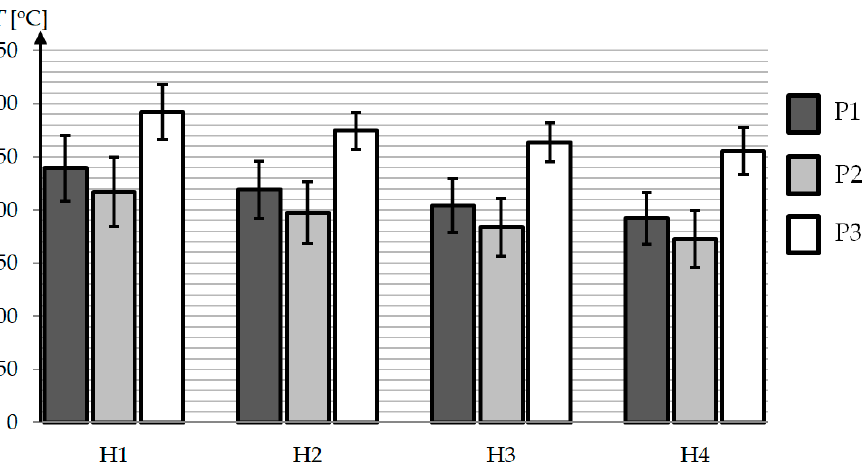
Figure 8. Cavity surface temperature for different geometries and distances between mold and inductor.